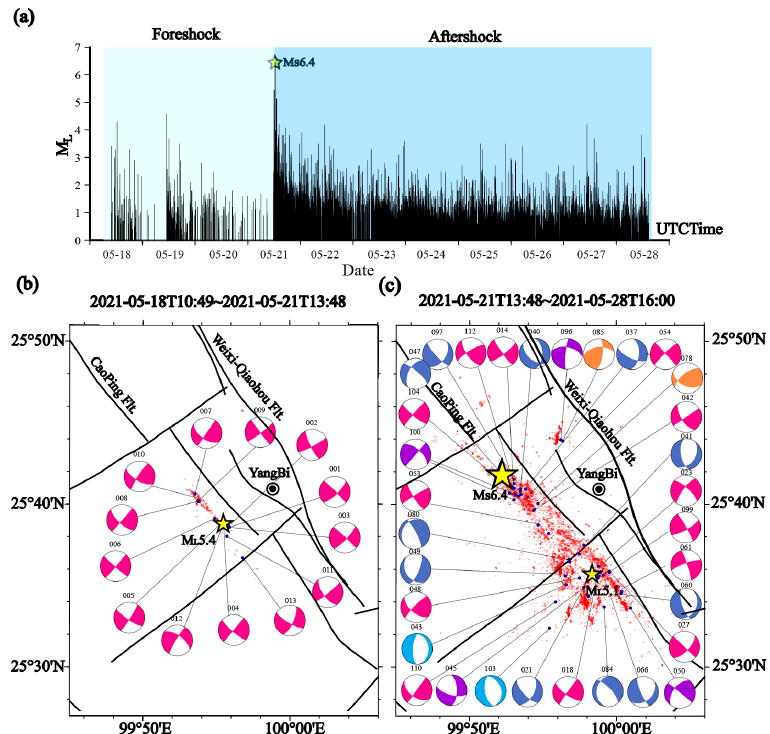
Figure 6. M-T diagram, earthquake distribution, and focal mechanism solutions for foreshocks and aftershocks. ( a ) M-T diagram of the Yangbi earthquake sequence. The yellow star indicates the mainshock. ( b ) Focal mechanism solutions of the foreshock sequence. ( c ) Focal mechanisms of the mainshock and aftershocks. The color of the beach ball represents different types of focal mechanisms (see Figure 5).